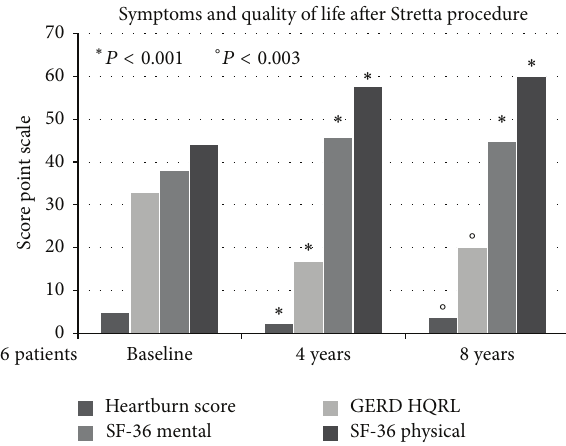
Figure 1: Means report 95% confidence intervals, medians report 25th and 75th percentile ranges, and proportions report percentiles. Heartburn score used a 6-point Likert scale: 0, no symptoms; 1, symptoms noticeable but not bothersome; 2, symptoms noticeable and bothersome, but not every day; 3, symptoms bothersome every day; 4, symptoms that affect daily life; 5, symptoms incapacitating (unable to perform daily activities). For symptom scores the statisti- cal tests compared the mean/median differences in absolute change frombaselinevalues.Heartburnandheartburn-relatedqualityoflife (HRQL) score: higher scores for worse symptoms. SF-36 physical score: higher scores for better function.